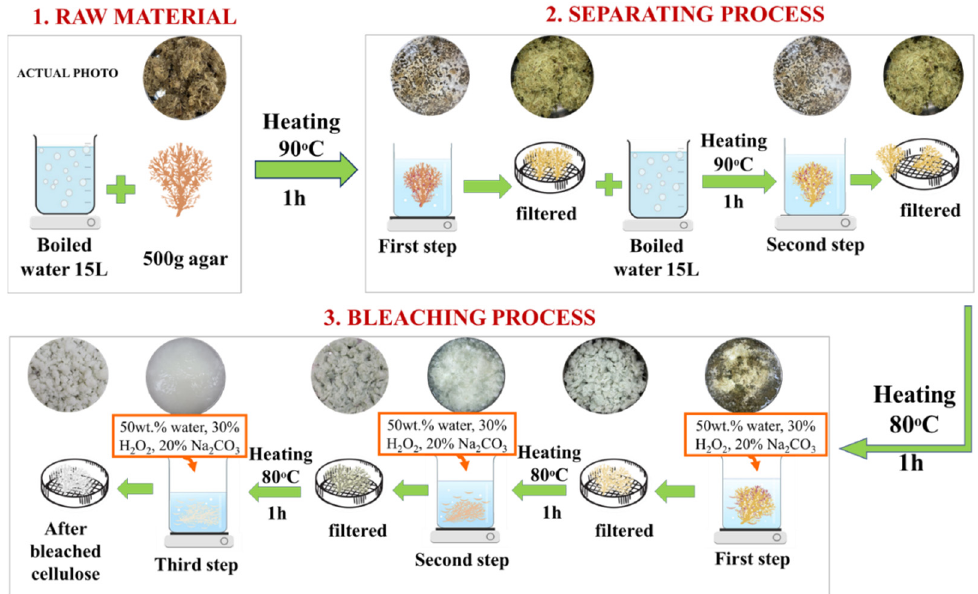
Figure 1. Scheme of the pretreatment process.